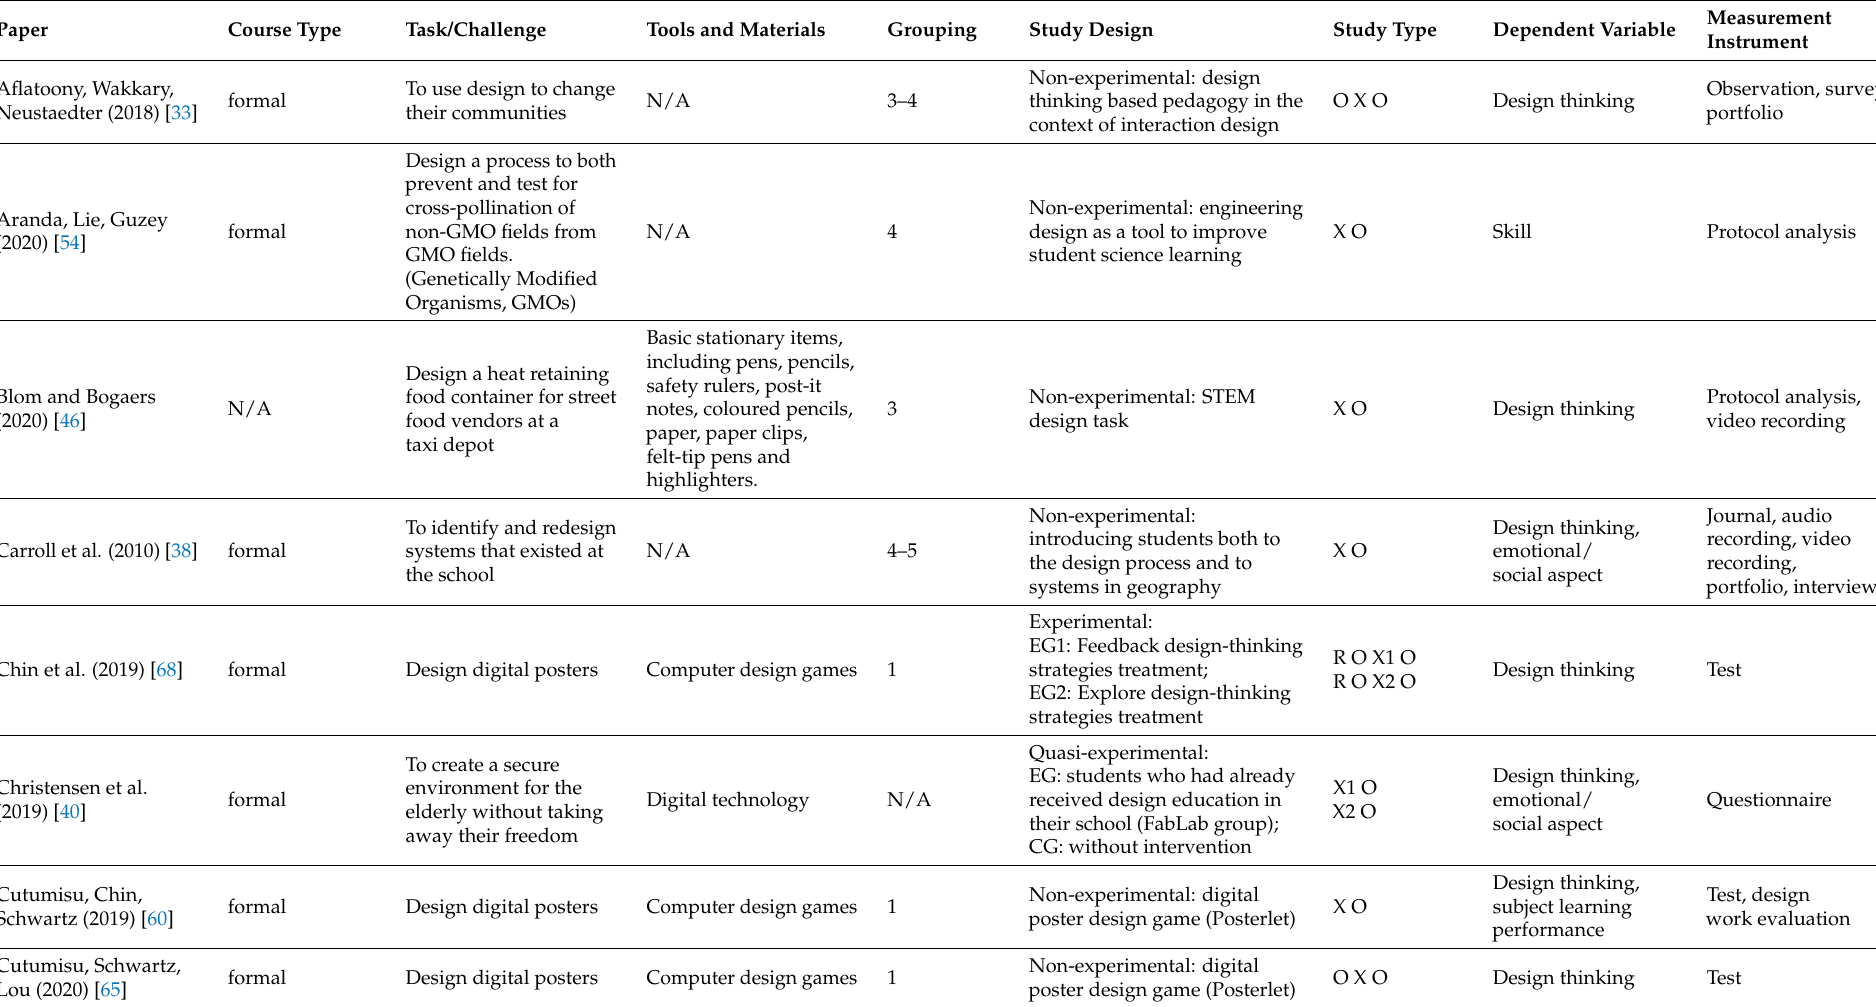
Table A2. Study design and